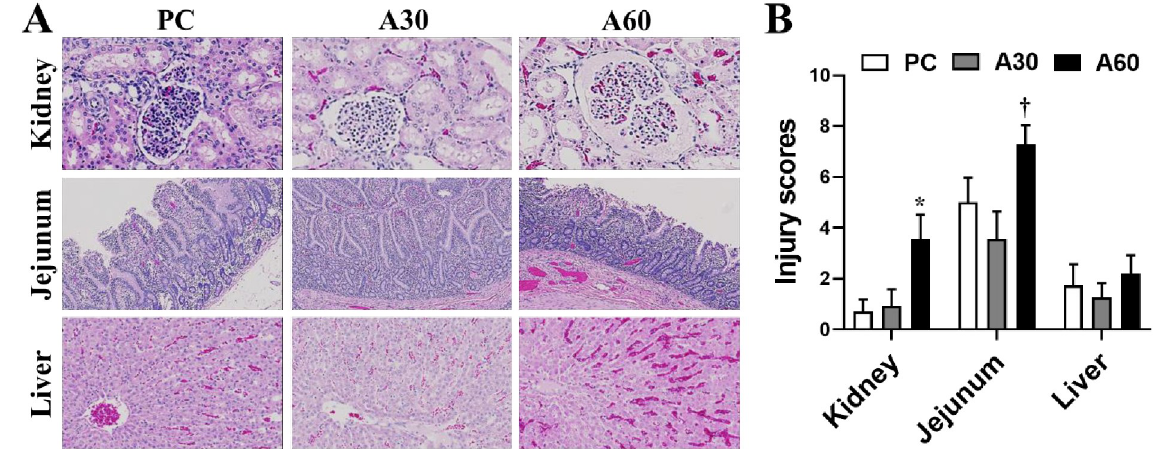
Fig 7. Histological alterations of end-organs in swine undergoing cREBOA. A, representative histological photos of kidney (top panel), jejunum (middle panel) and liver (low panel). B, semiquantitative evaluation of the pathological features. Data are presented as mean ± SEM and were statistically analyzed using two-tailed Mann-Whitney test. � p < 0.05, PC vs . A60 group; † p < 0.05, A60 vs . A30 group.